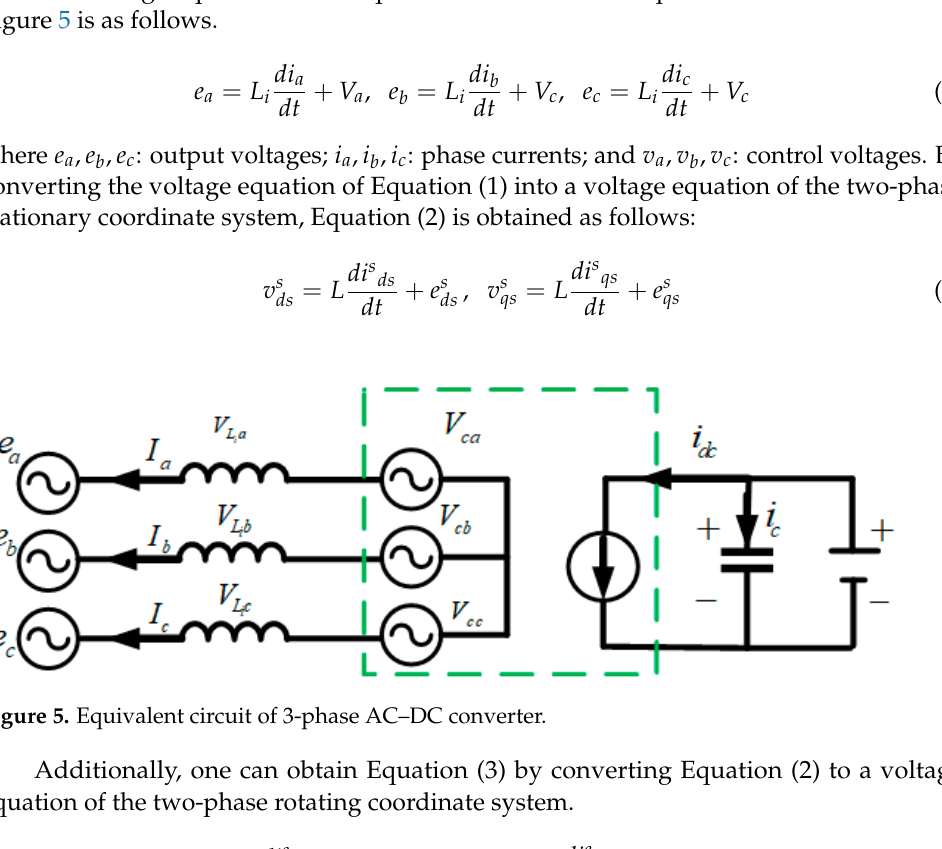
The voltage equation of the equivalent circuit of the 3-phase AC–DC converter in Figure 5 is as follows.